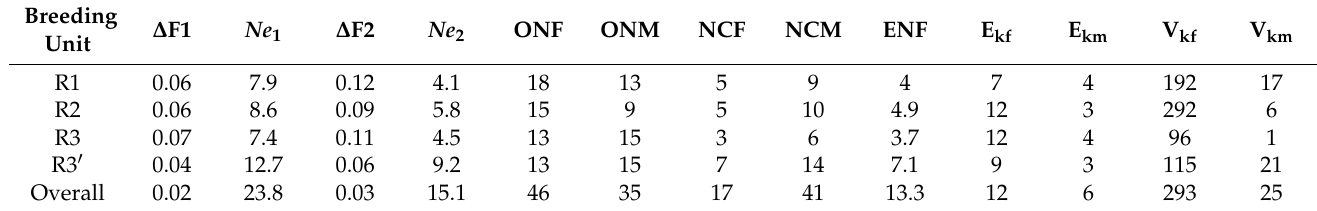
Table 1. Predicted rates of inbreeding and effective population size ( Ne ) for different production batches. DF 1 (Predicted rate of inbreeding: Wooliams and Thompson, 1991); Ne 1 ( Ne : Wooliams and Thompson, 1991); DF 2 , (Predicted rate of inbreeding: Waples and Waples, 2005); Ne 2 (Waples and Waples, 2005); ONF (Observed number of females); ON M (Observed number of males); N F (Number of contributing females); N M (Number of contributing males); ENF, (Effective number of founders); E kf (Average family size of females); E km (Average family size of males); V kf (Variance of family size of females); V km (Variance of family size of males). R3 (cid:48) corresponds to a different production batch from the breeding unit